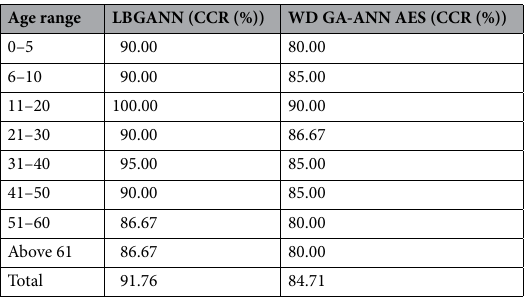
Table 4. Correct classification rate for LBGANN and WD GA-ANN